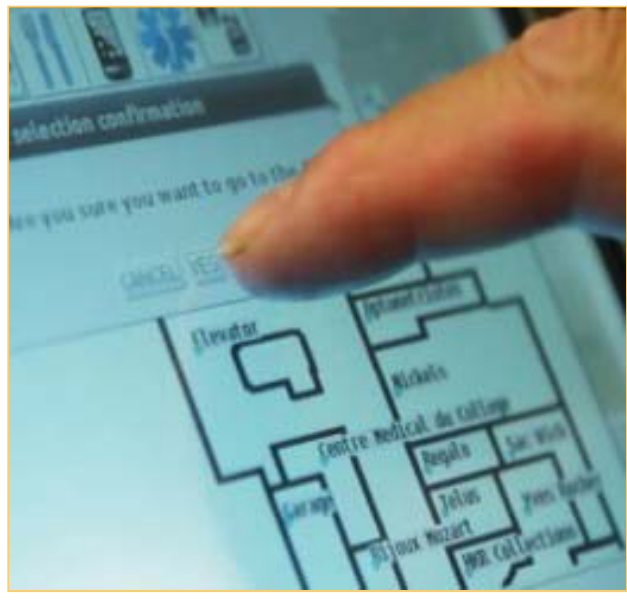
Figure 2. Tactile interface illustrating intelligent power wheelchair path finding